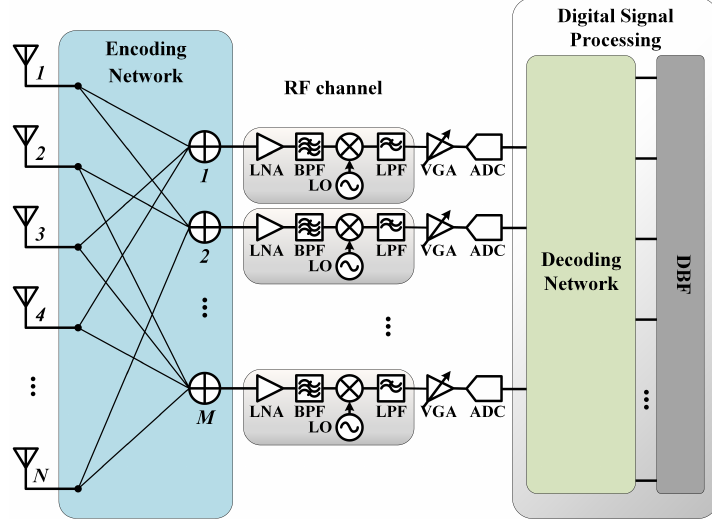
Figure 1. The block diagram of the proposed